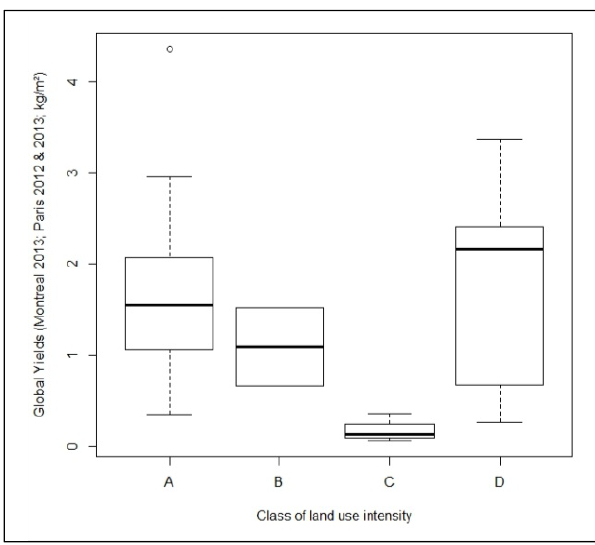
Figure 12. Average Yields per Class of Land-Use